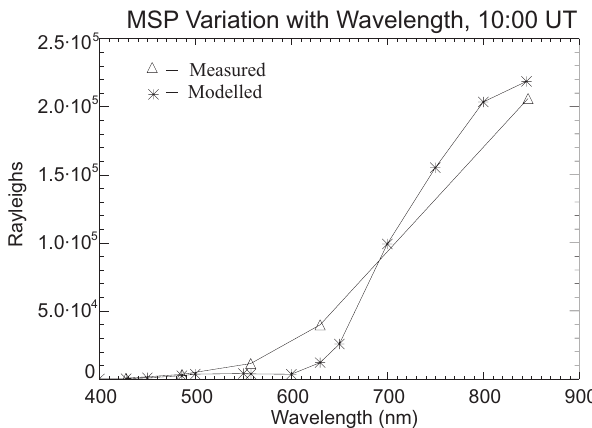
Fig. 5. The variation of the red sky signal with wavelength as measured by the MSP (triangles). Although the spectrum is coarsely sampled by the MSP (428nm, 486nm, 558nm, 630nm and 845nm) it is clear the red wavelengths( > 600nm) dominate over the shorter wavelengths. The plot is taken at 10:00 UT at an elevation of 10 ◦ . The corresponding model output is also shown for comparison (stars).